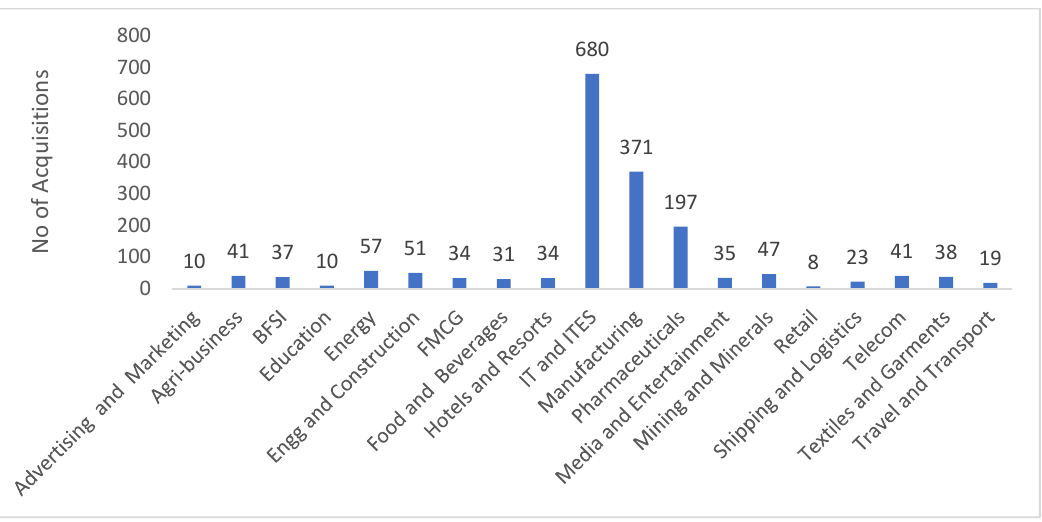
Figure 1. Industry wise CBA during 2005 to 2017. Source: Venture Intelligence database.